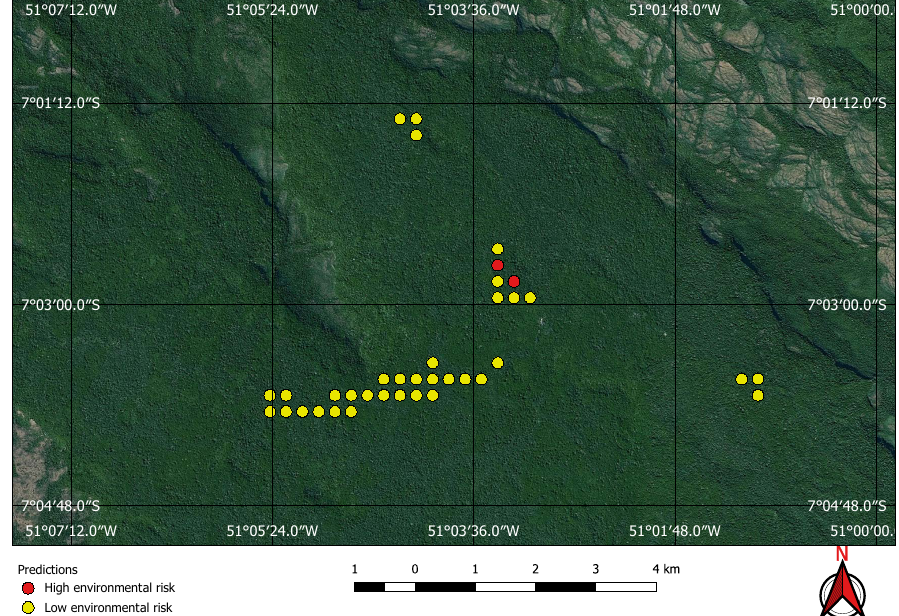
Figure 21. True positives on the Kayapo’s protected land not visible on Google